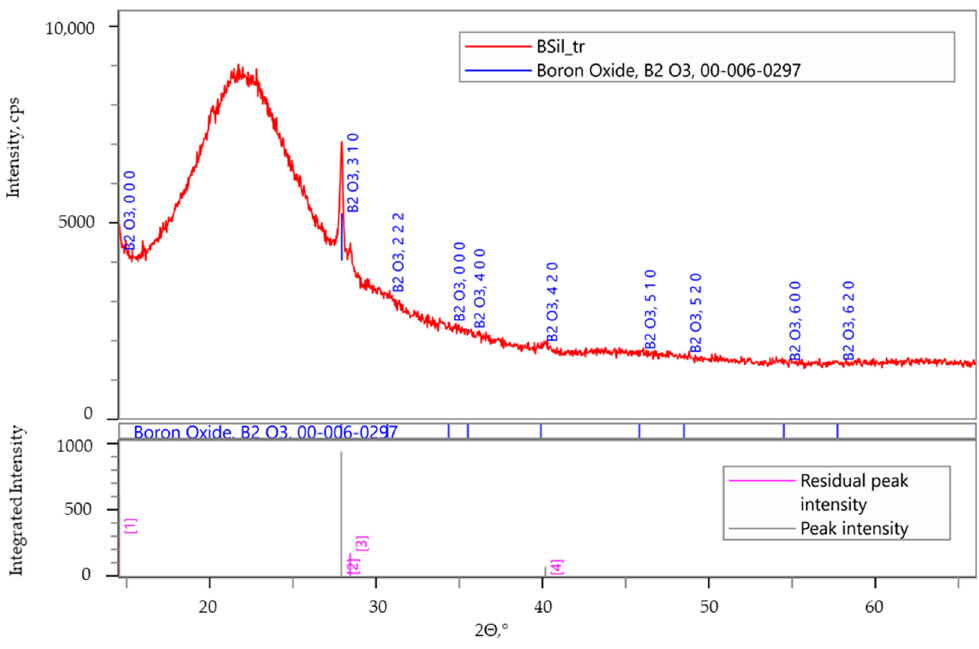
Figure 9. XRD analysis of the used immobilized catalyst BSil.